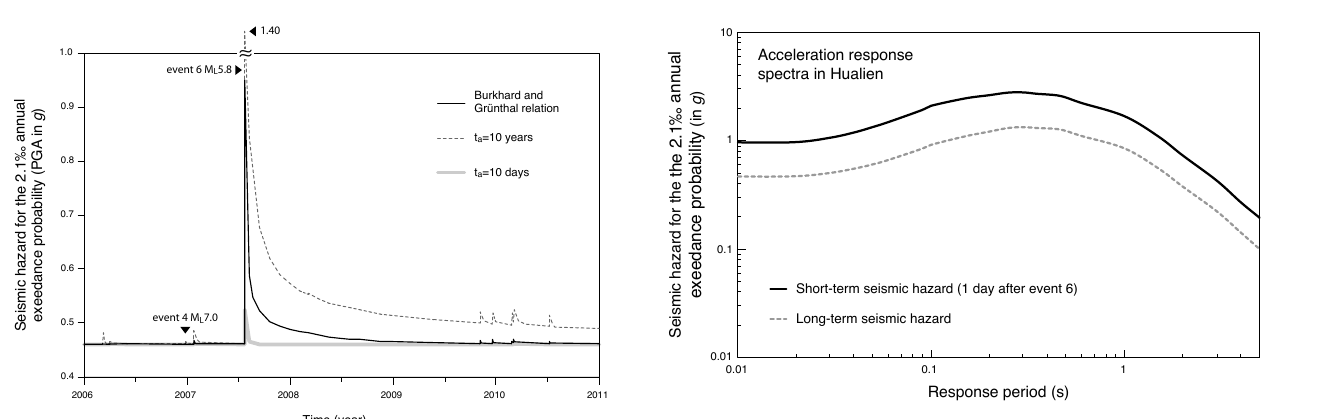
Fig. 6. Assumed aftershock durations, t a , as the Burkhard and Gr¨unthal (2009) relation (black line), 10yr (dashed line), and 10 days (light-gray line); the temporal evolution of the seismic haz- ard for the 2.1‰ annual exceedance probability in Hualien City from 2006 until 2010. Variations in the seismic hazard can be at- tributed to the seismicity rate change imparted by source events (Fig. 5).